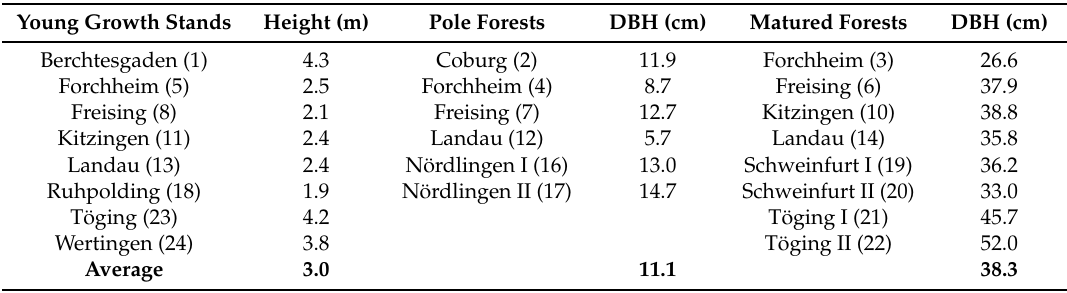
Table 1. Mean height and diameter of trees at breast height in the study sites, plot number indicated in brackets.